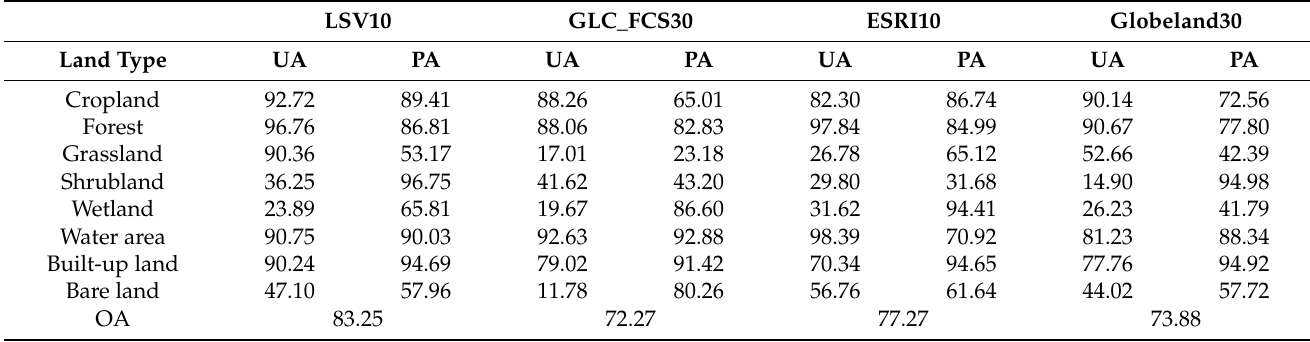
Table 5. Validation accuracy of the multisource LULC dataset (%). LSV10 GLC_FCS30 ESRI10